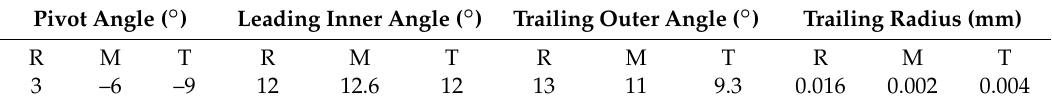
Figure 29. Study of the stator trailing axial chord. Table 9. Final parameters of the stator’s leading edge blade profiles.